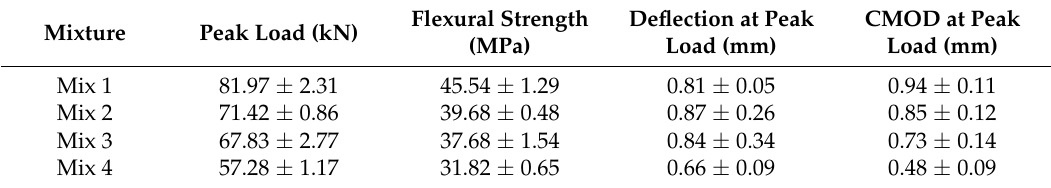
Table 2. Flexural test